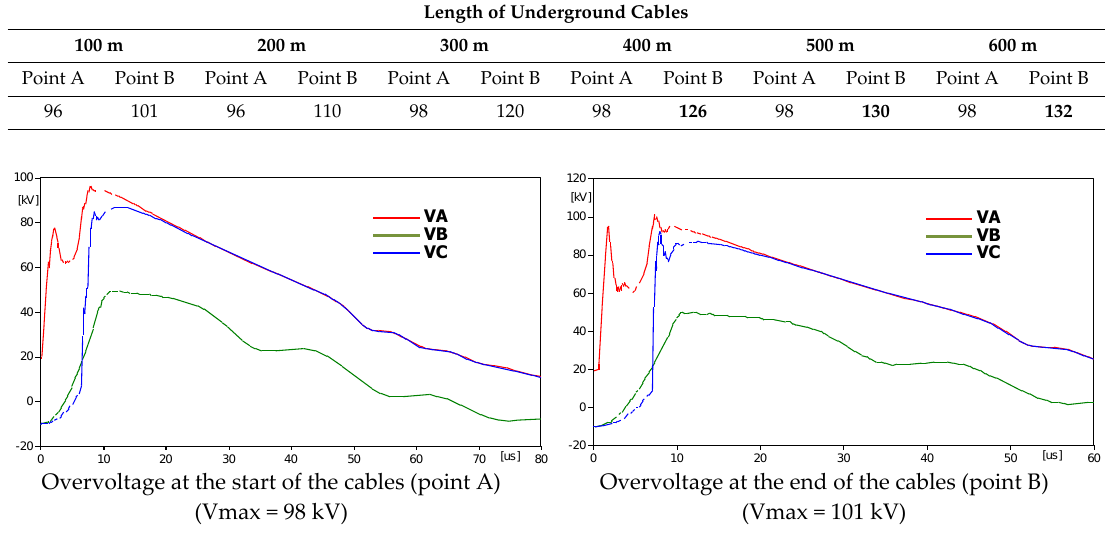
Figure 35. A 100 m underground cable.